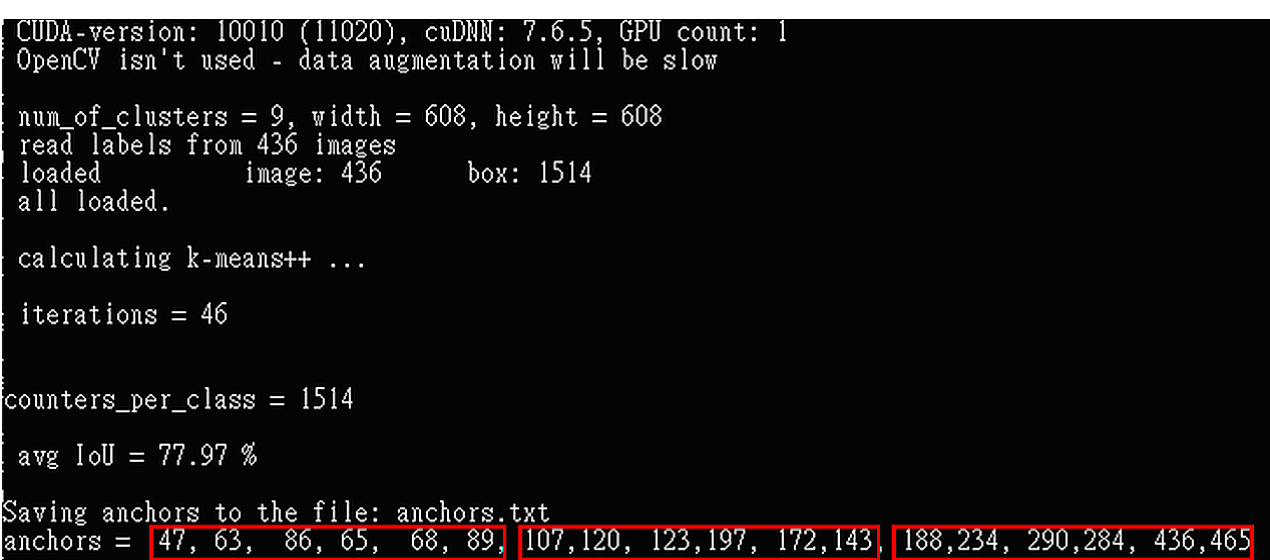
Figure 10. Calculating anchors of YOLOv4-CSP model.